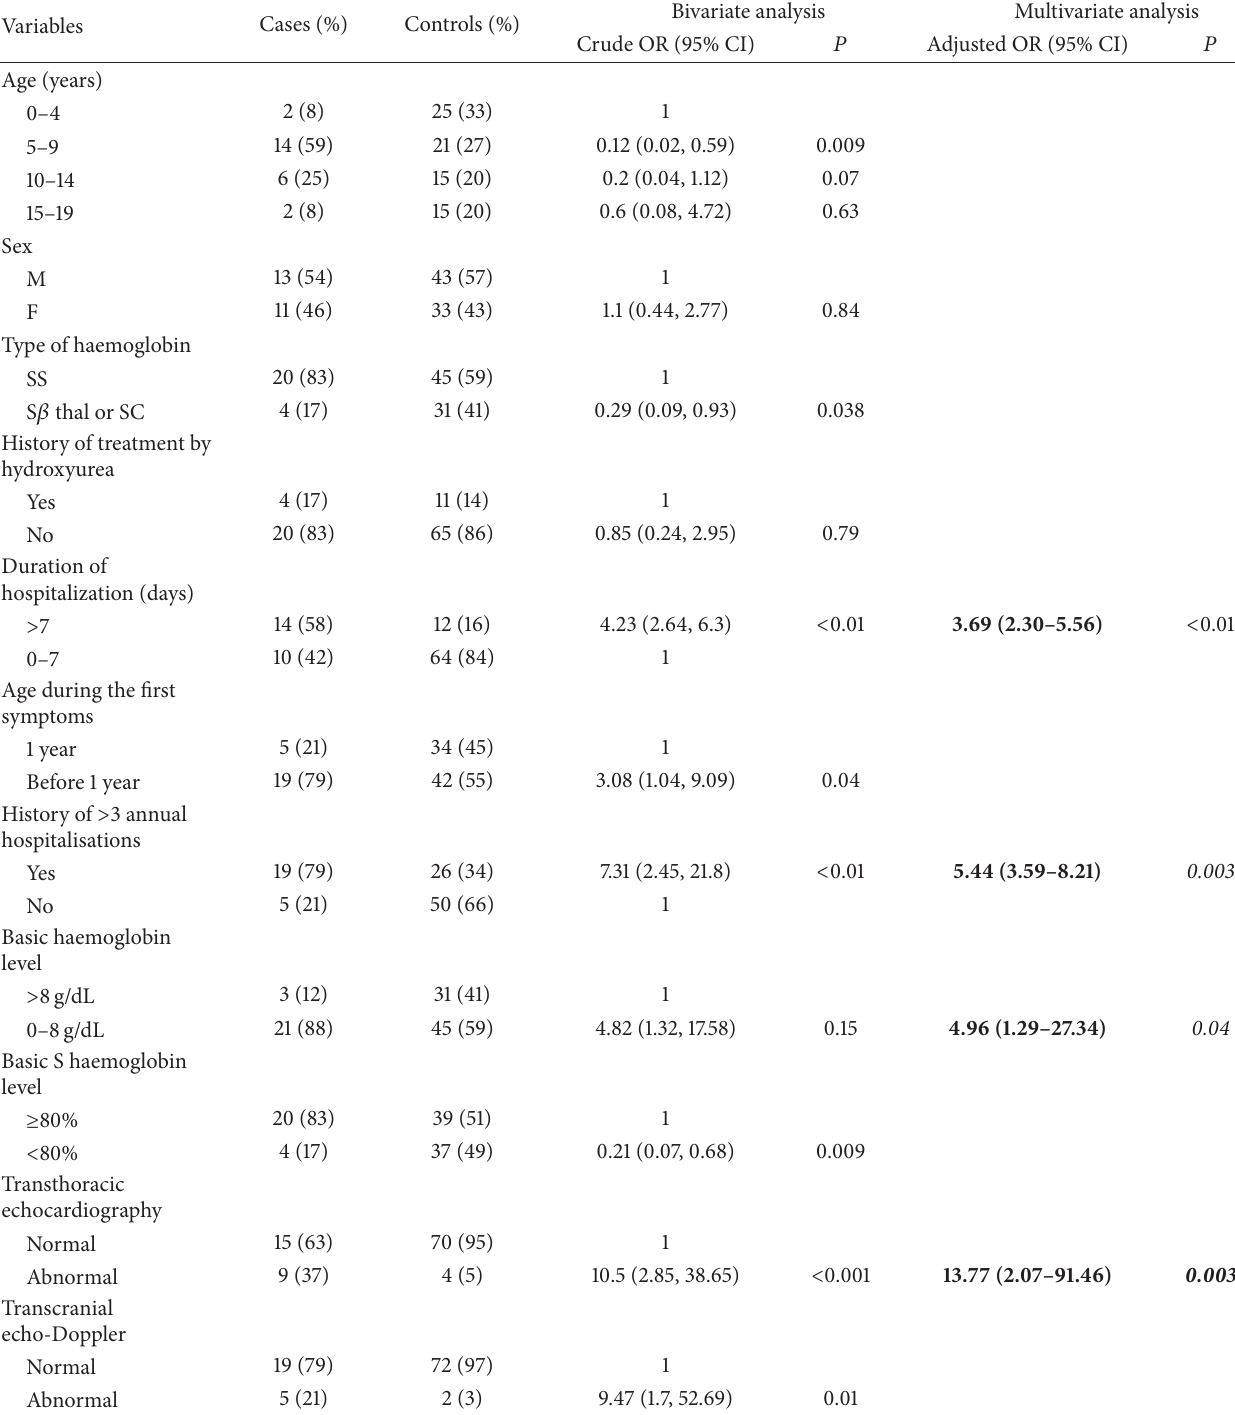
Table 1: Case and control description and bivariate and multivariate analysis ∗